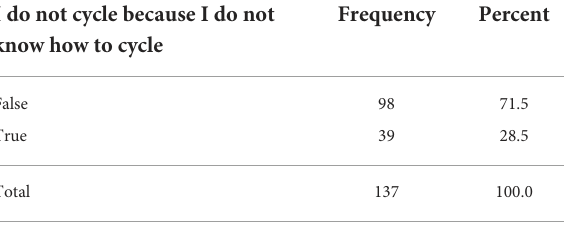
TABLE 9 Location of interview by walking and cycling